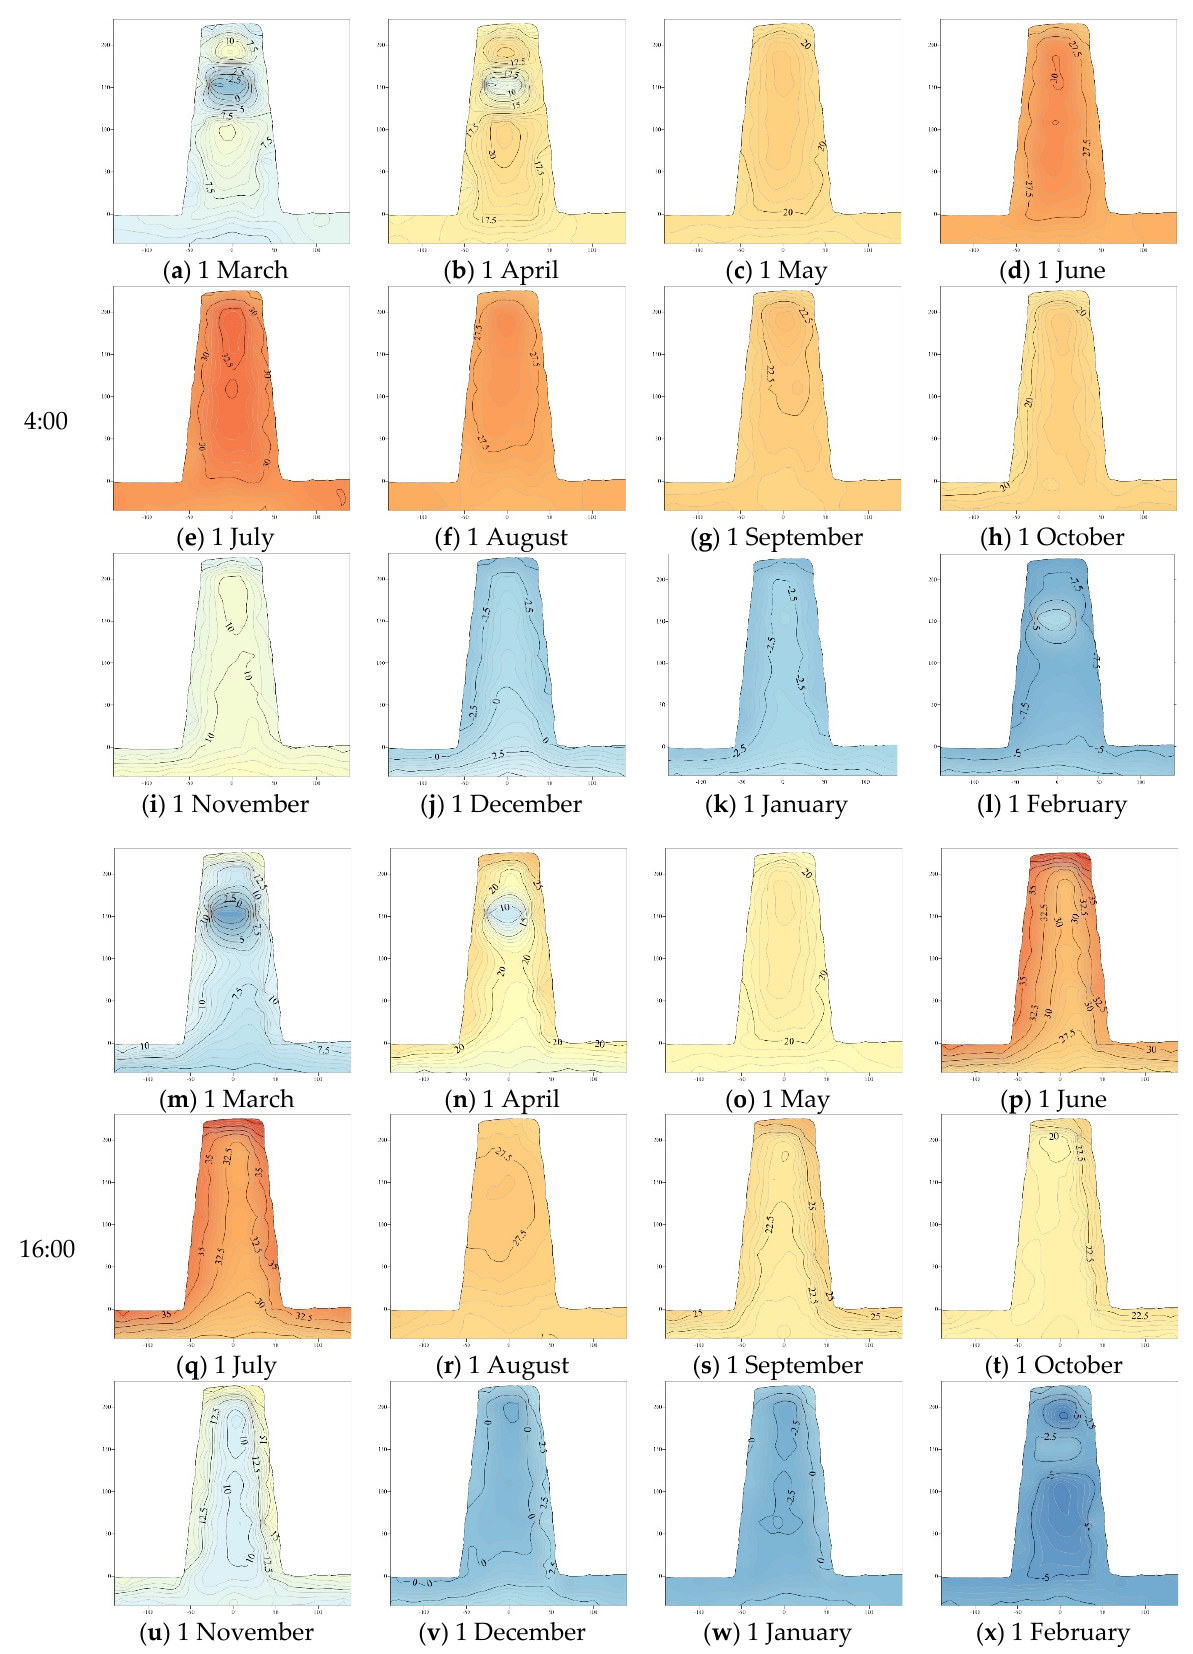
Figure 6. Trend charts showing changes in temperature field isotherms at 4:00 and 16:00 in one year.